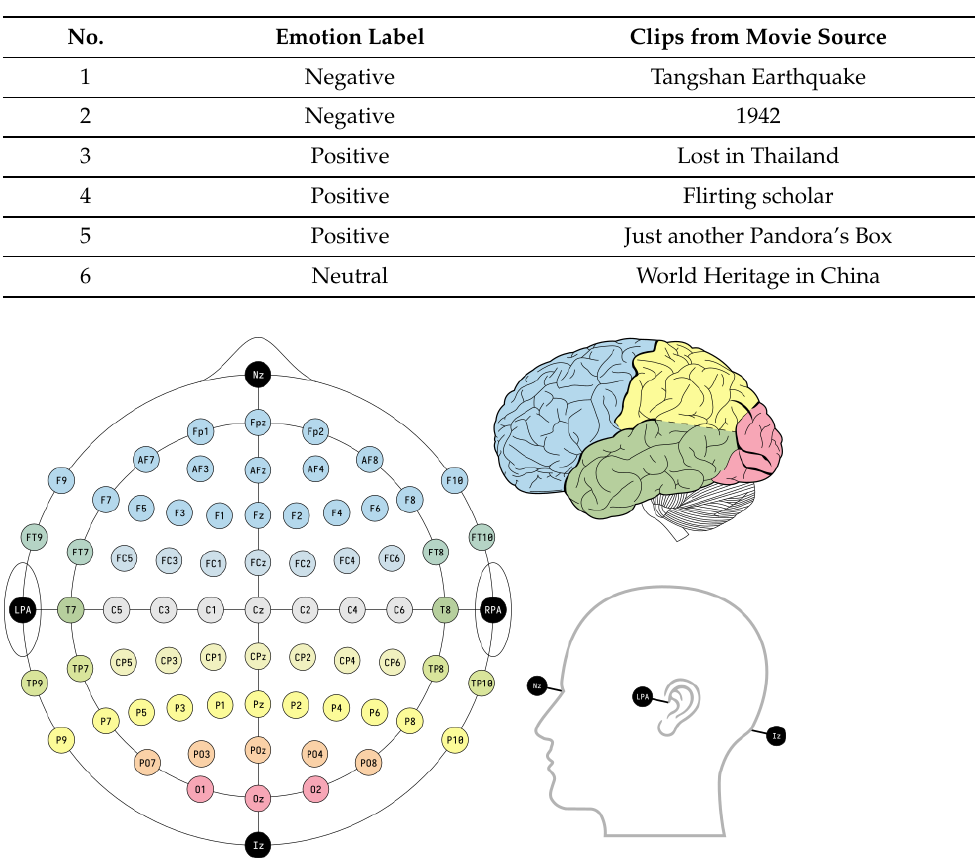
Table 2. Description of Clips that invoke Positive, Negative, Neutral Emotions.